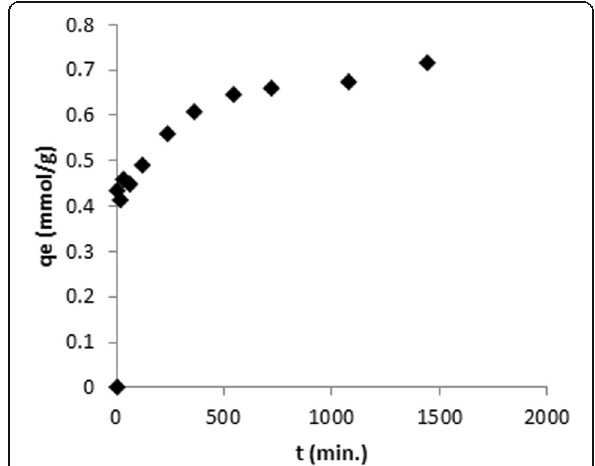
Fig. 13 Time effect on Cr (VI) adsorbed by N6,6/GO (pH: 2, dosage: 2 g/L, temperature: 25 °C)